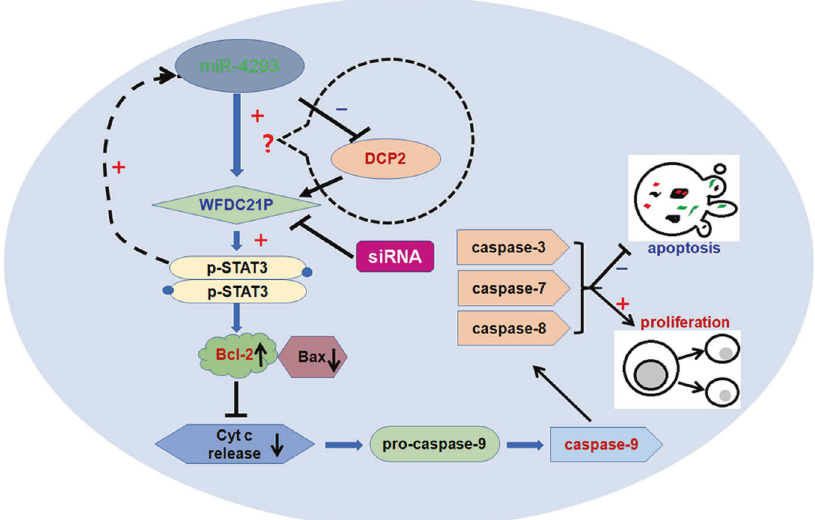
Fig. 7 miR-4293 regulating WFDC21P through DCP-2. miR-4293 promotes tumor cell proliferation and metastasis but suppresses apoptosis. DCP2 can directly or indirectly bind to and downregulate WFDC21P. By targeting DCP2 mRNA, miR-4293 suppresses the expression of DCP2, and further enhances the expression of WFDC21P and promotes STAT3 phosphorylation. As a result of elevated STAT3 activity, apoptosis is suppressed and proliferation is enhanced through Bcl2 elevation, Bax2 attenuation and reduced caspase cleavage. In addition, WFDC21P elevates miR-4293 expression by promoting STAT3